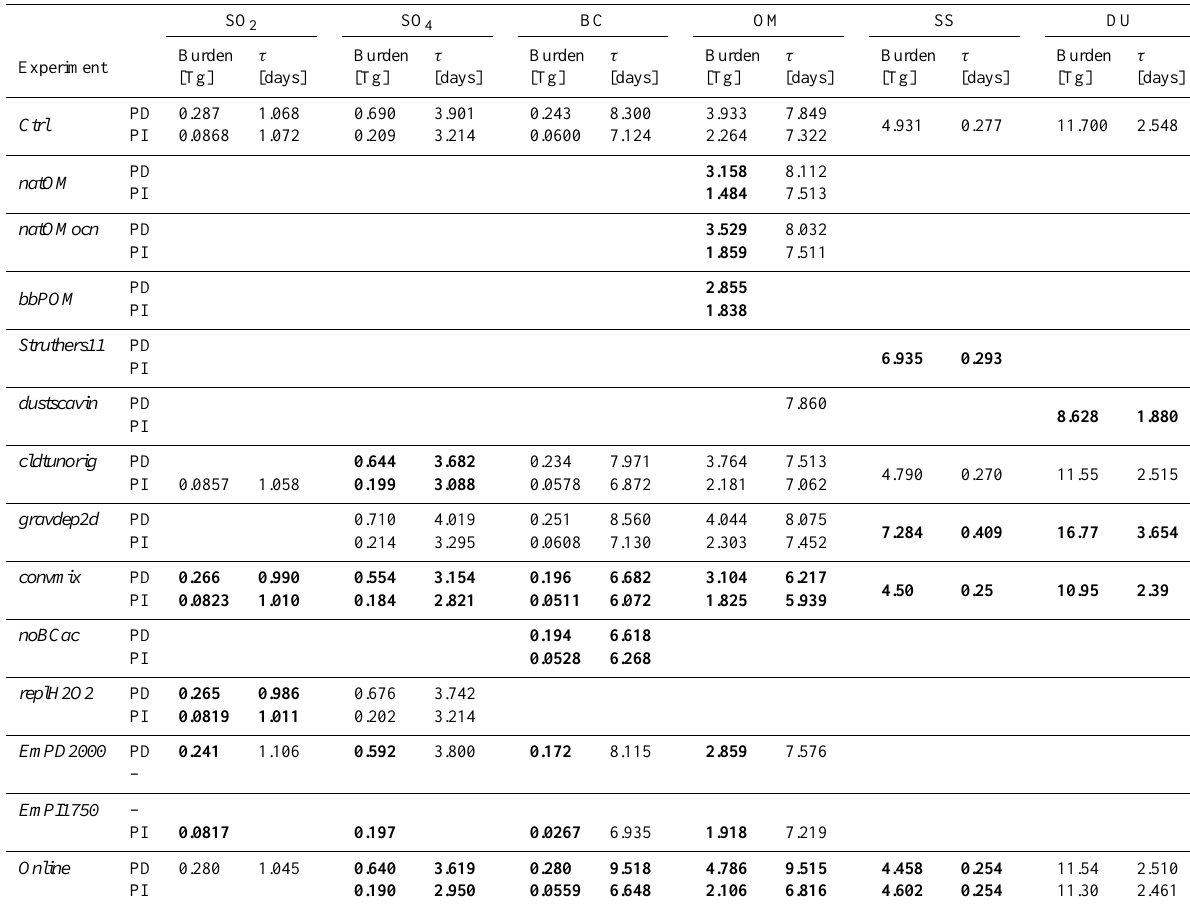
Table 6. Calculated global annual burdens and residence times ( τ ) for the individual modelled species for the sensitivity tests defined in Table 5. Data from the Ctrl and the Online experiments are from the simulation year 7. The sensitivity tests are restarted from the Ctrl PD and PI experiments 11 months before the beginning of year 7, taking the first 11 months as spin-up. Results of the sensitivity tests are shown when their changes relative to Ctrl are larger than 1% (normal types) and 5% (bold types). The upper values in a table cell are for present-day emissions (PD) and the lower for preindustrial emissions (PI). For the no coating and prescr β experiments, burdens and residence times are identical to Ctrl